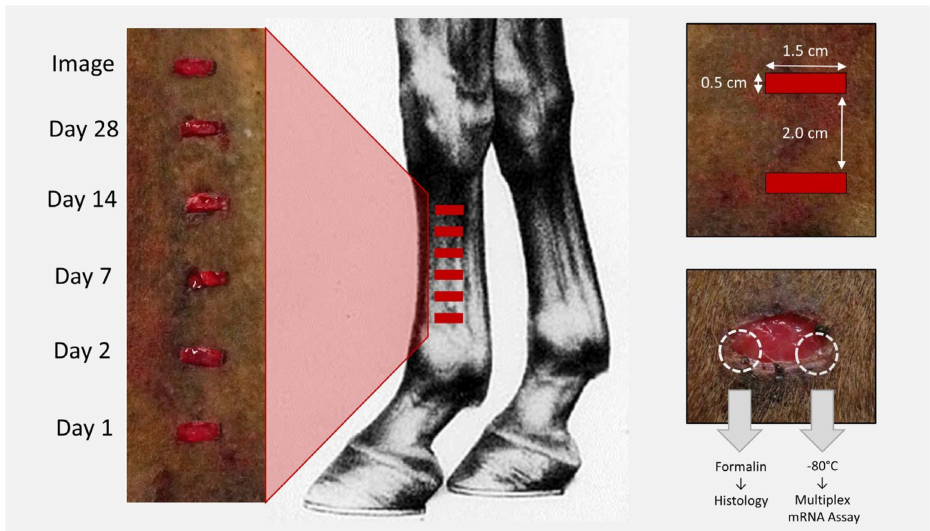
Figure 2. Basic schematic of wound creation and sequence of biopsy collection. On day 0, six wounds were created on the left forelimb of each horse measuring 0.5 cm × 1.5 cm and placed 2 cm apart in a vertical orientation. On days 1, 2, 7, 14, and 28, a biopsy was collected from both the dorsal and palmar aspects of the wound in a distal to proximal sequence. The dorsal biopsy was submitted for histology and the palmar biopsy was snap frozen for later cytokine mRNA multiplex assays. The top wound was left to heal by second intention and imaged on days 7, 14, and 28 and assessed by planimetric analysis for rate of wound